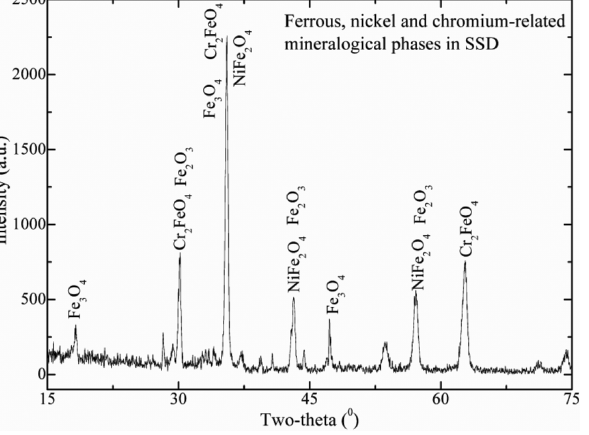
Figure 3: Mineralogical phases in stainless steel dust.